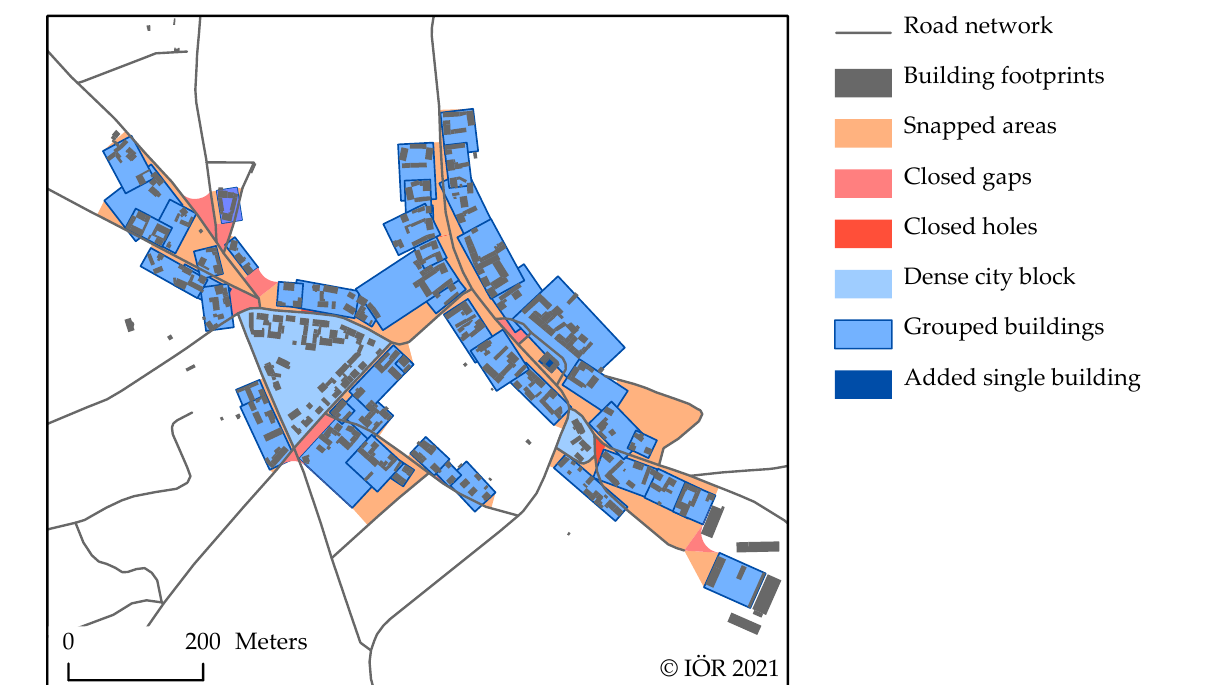
Figure 7. Visualisation of the refinement process: In a first step, areas between dense blocks, grouped buildings and single buildings are closed. This is followed by the closing of gaps and holes. Finally, all geometries are merged into a single geometry. ( source : own illustration based on data from ATKIS ® Base-DLM © Geobasis-DE/BKG